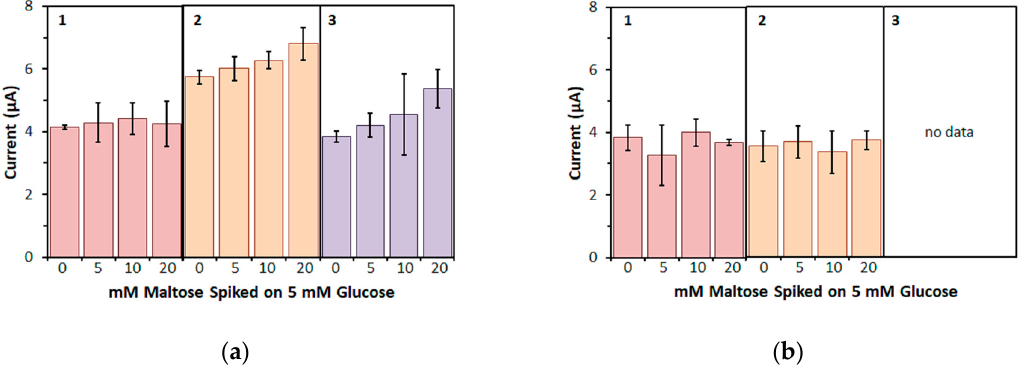
Figure 5. Response current to 5 mM glucose spiked with different amounts of maltose. Enzyme: ( a ) FADGDH γαβ (QY), ( b ) Af GDH. Mediator: (1) 100 mM mPMS, (2) 100 mM ferricyanide, (3) 100 mM hexaammineruthenium(III).